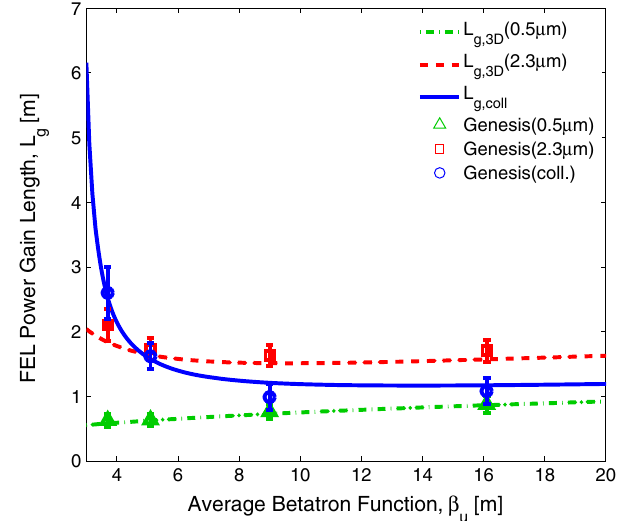
FIG. 3. Gain length as a function of the average betatron function in the undulator, analytical (lines) and from Genesis simulation (symbols), with parameters from Table I. The gain length from simulations fits the FEL power growth along the undulator. Error bars show the maximum variation of the fit value over several runs. For each run used to fit L (blue circles), g; coll several random distributions of the bunch ’ s macroslices in the transverse phase space were generated. In this case, each distribution (in each transverse plane) corresponds to a normal- ized projected emittance of 2 . 3 μ m, while the slice emittance is 0 . 5 μ m for all slices. The projected beam size is forced to fit the average betatron function selected for that run. In the two other cases shown in the figure, the projected and the slice normalized emittances coincide, with values 0.5 (green triangles) and 2 . 3 μ m (red squares), respectively. The average betatron function in the abscissa is the geometric mean of the horizontal and the vertical β averaged along the undulator.